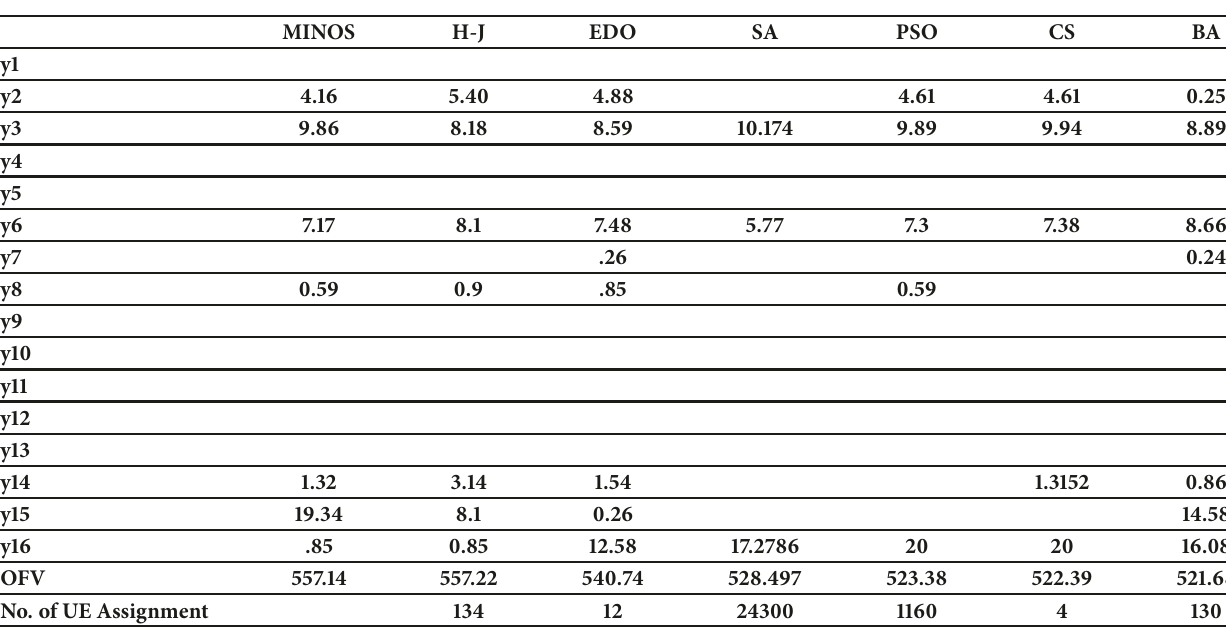
Table 5: Solution of demand scenario 2 for